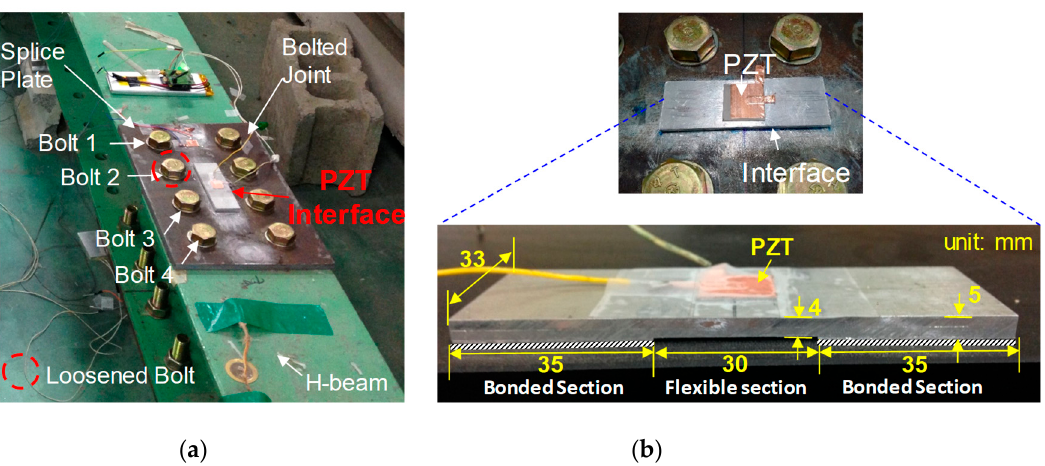
Figure 1. Experimental setup of the lab-scaled steel beam: ( a ) setup of bolted joint; ( b ) prototype of PZT interface.